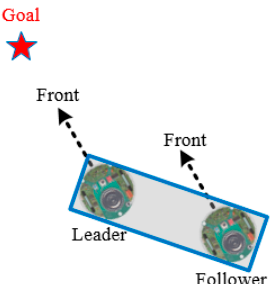
Figure 23. Follower and leader move in the same direction and at the same speed.